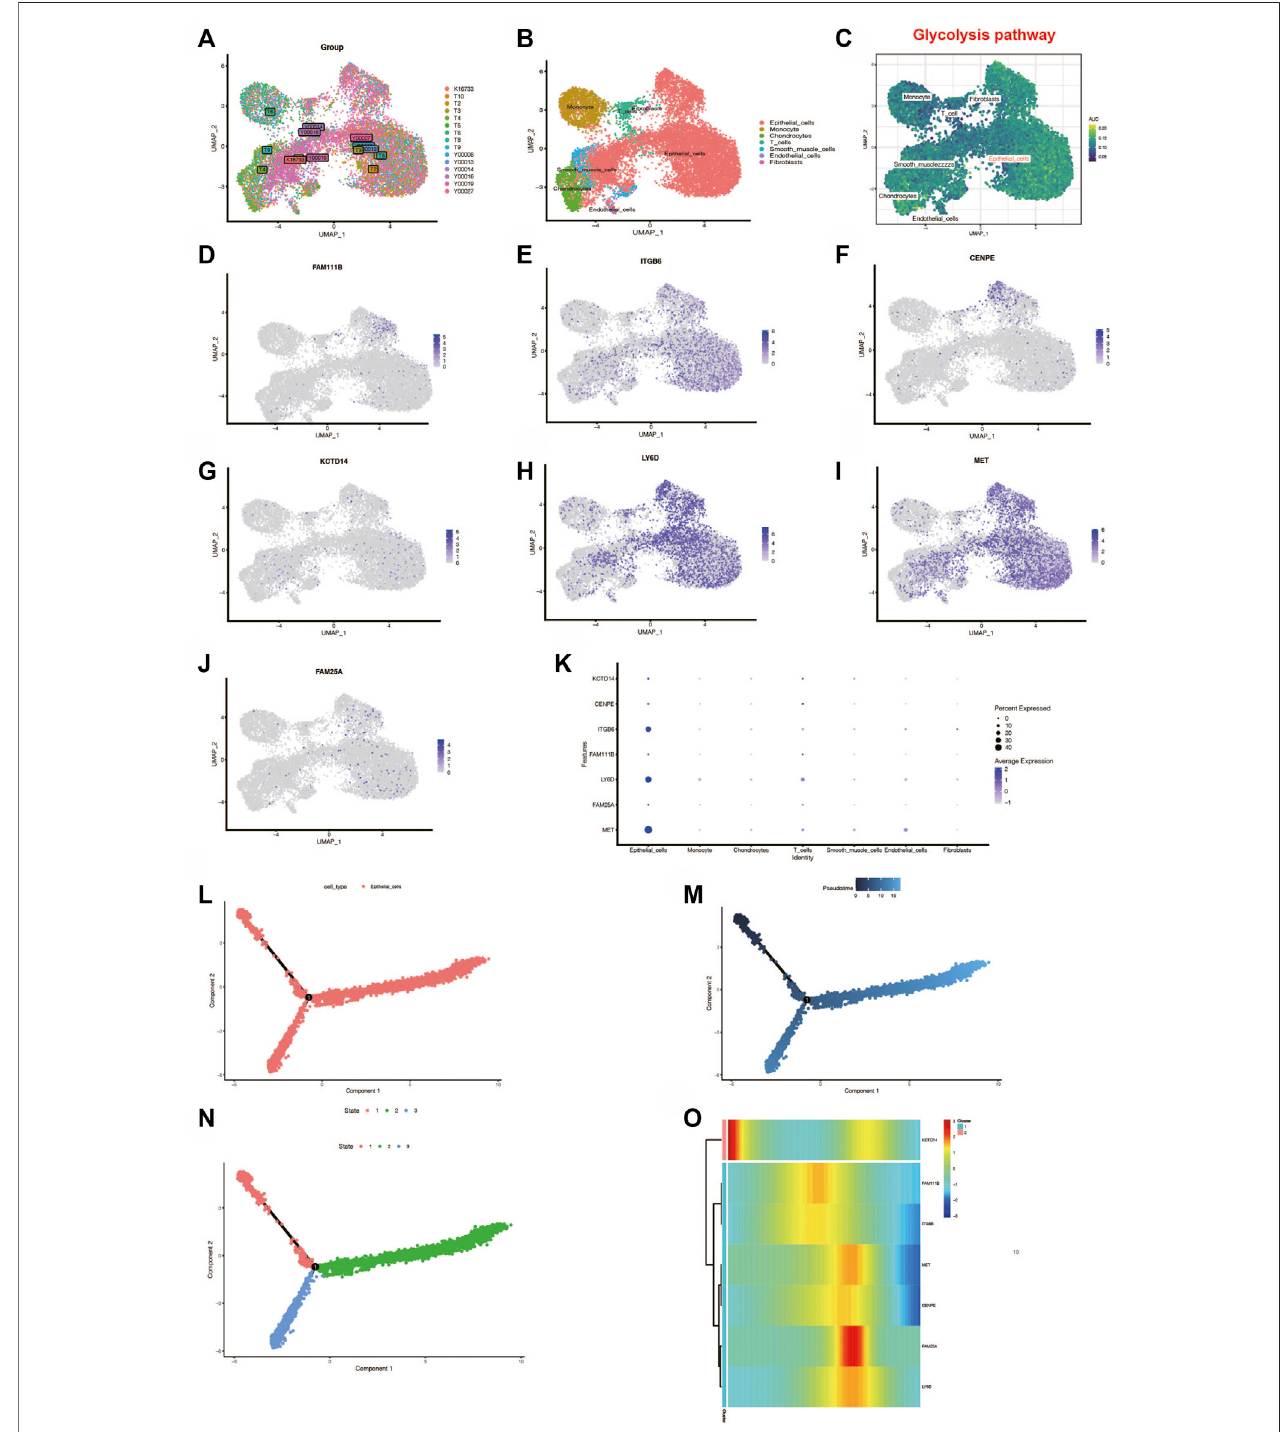
FIGURE8| Single-cellanalysis. (A) FifteensampleswereintegratedwiththeCCAmethod. (B) Dimensionreductionandclusteranalysis.Thecelltypeswereshown withtheumapplot. (C) Glycolysispathwaywasactivatedindifferentcelltypes (D – K) .Genesintheprognosticsignatureexpresseddifferentlyindifferentcelltypes. (L – N) Analysis of epithelial cell locus differentiation and (O) the genes in the signature expressed differently during the epithelial cell locus differentiation.